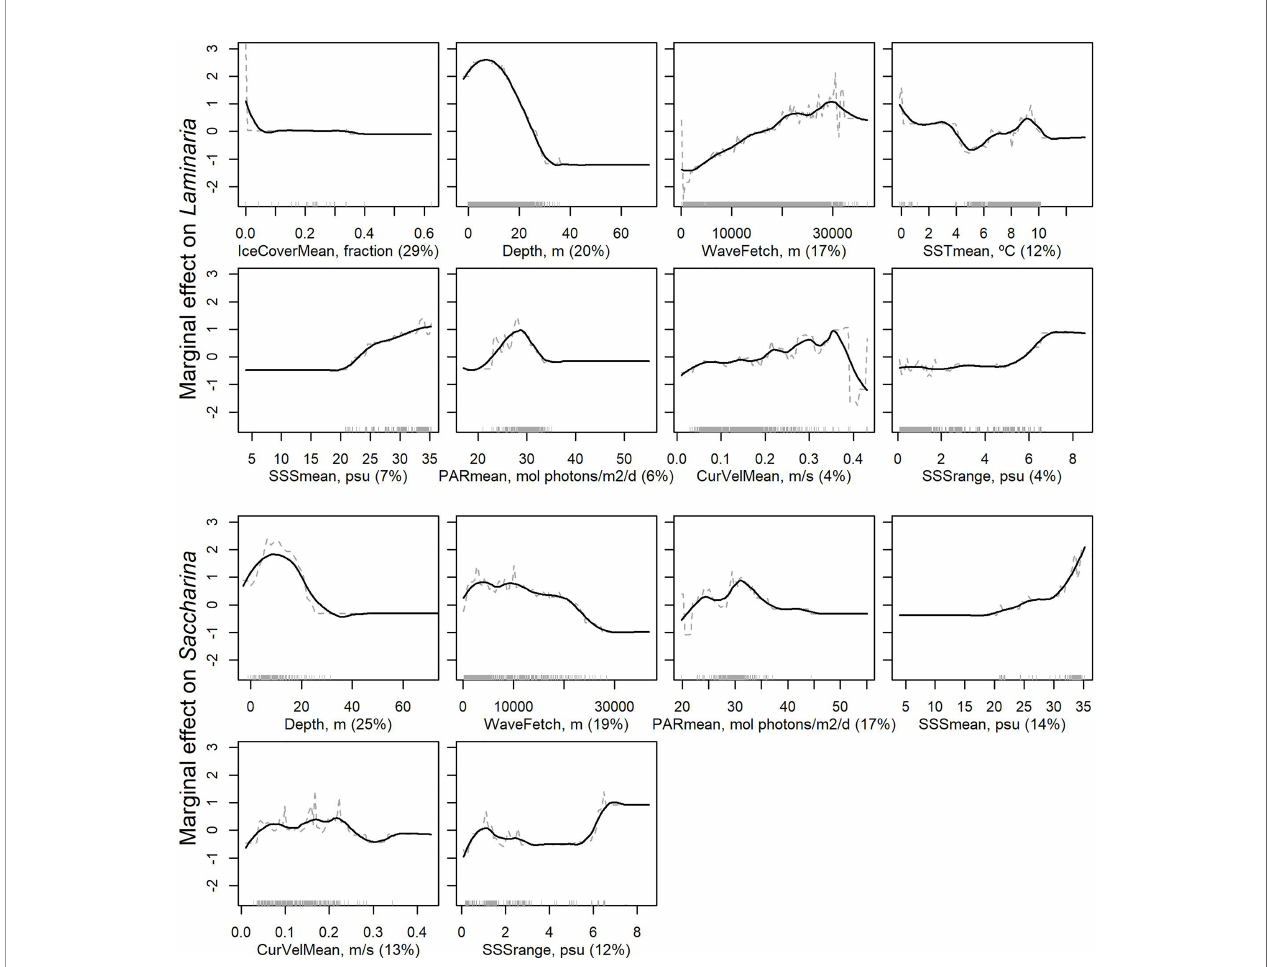
FIGURE 4 | Partial dependence of presence of Laminaria (two upper rows) and Saccharina (two lower rows) forests to the environmental variables kept in the fi nal models, sorted according to degree of in fl uence. The plots show the effect of a variable after accounting for the average effects of all other variables in the model. Grey dashed lines show the marginal effect of the variable and solid black lines give a smooth representation of the response. Numbers in brackets provide the relative contribution of the given variable. The grey rug on the x-axis shows the location of data with recorded presence of Laminaria or Saccharina kelp forest, while the x-axis range is determined by the full datasets including absences.